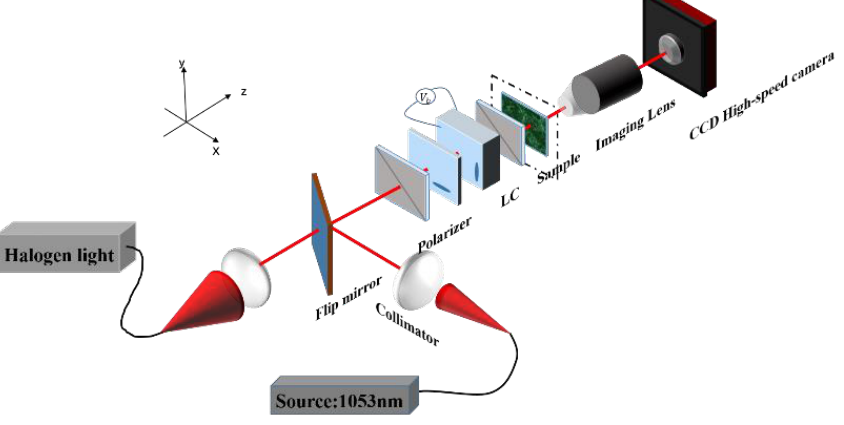
Figure 2. Experimental setup of the interference spectral imaging system based on LC relaxation.